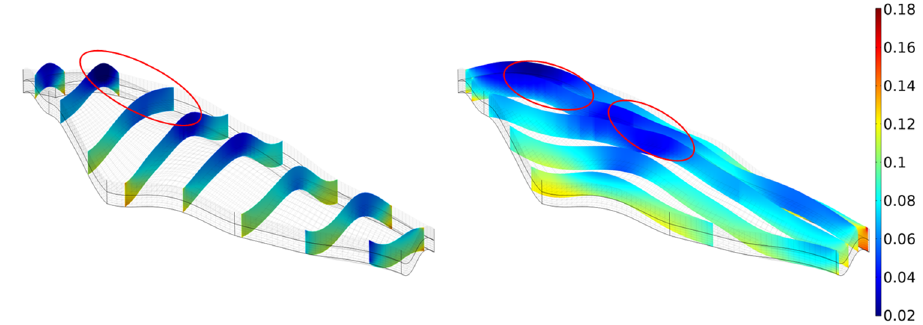
Figure 12. Longitudinal section of steady ‐ state flow field of regolith.